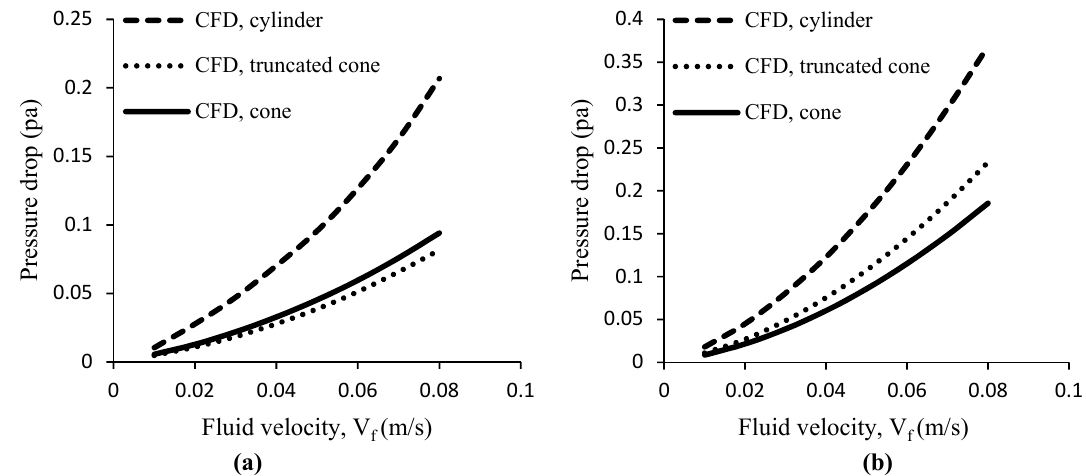
Fig. 11. Pressure drop variations vs. fluid velocity for cylindrical, truncated cone, and cone particles in a laminar flow regime: a) V 8.34×10 5 mm 3 and b) V = 94.9×10 5 mm 3 . b